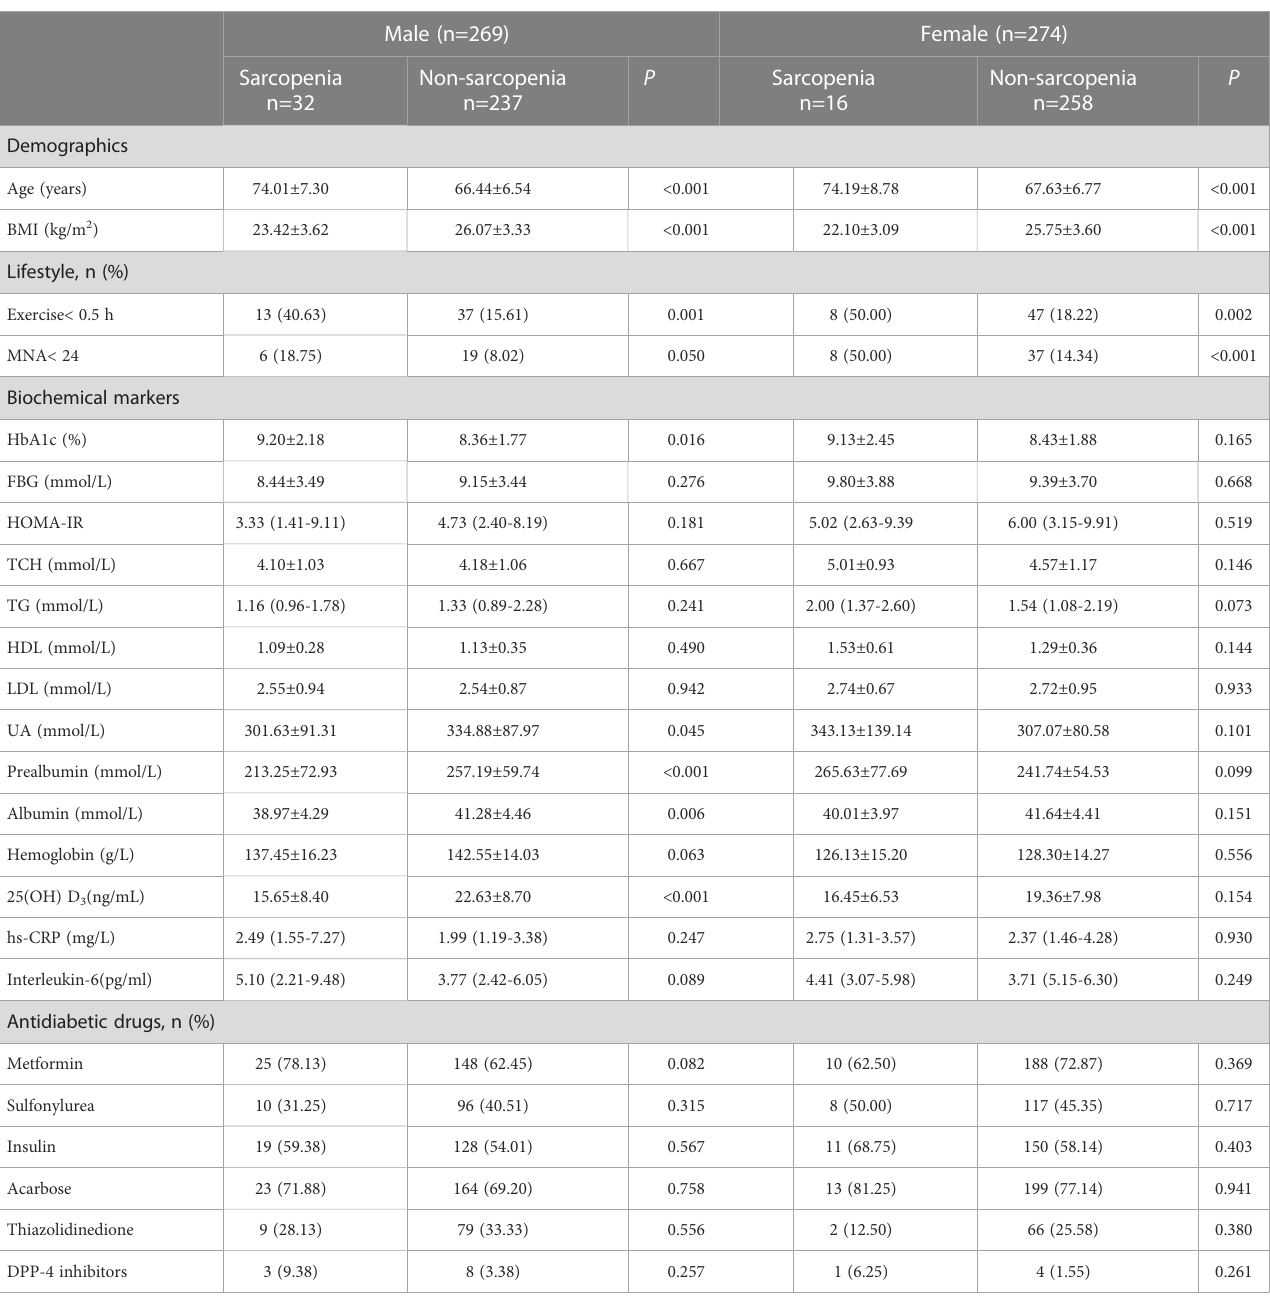
TABLE 2 Characteristics of the participants according to sex and sarcopenia